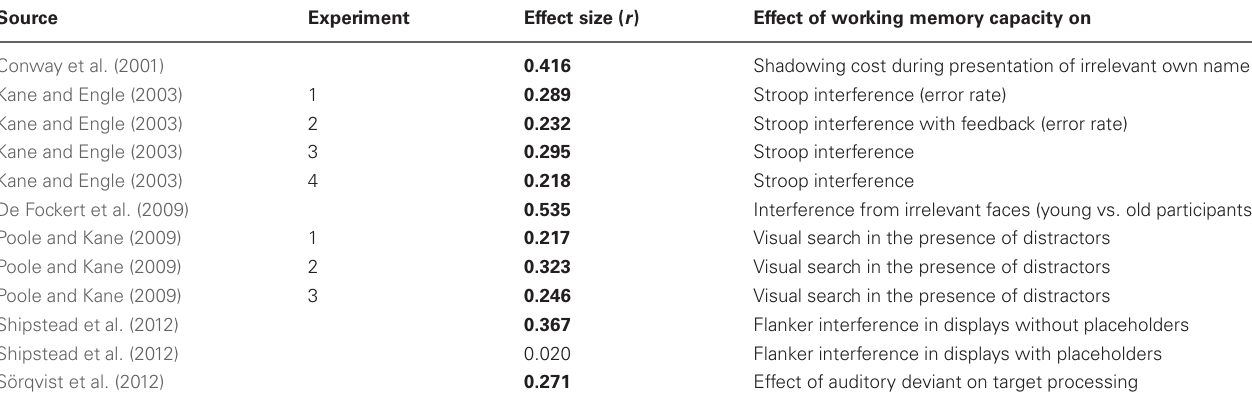
Table 2 | Effect sizes ( r ) for the effect of working memory capacity on distractor processing (reaction time effects, unless stated otherwise; high vs. low score on working memory span measure, unless stated